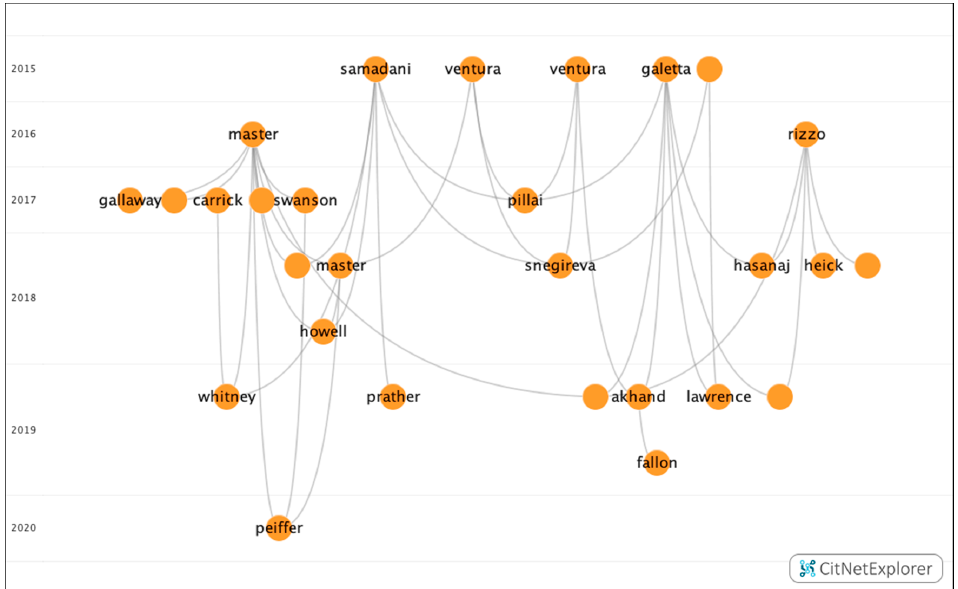
Figure 7. Citation network in group 4.